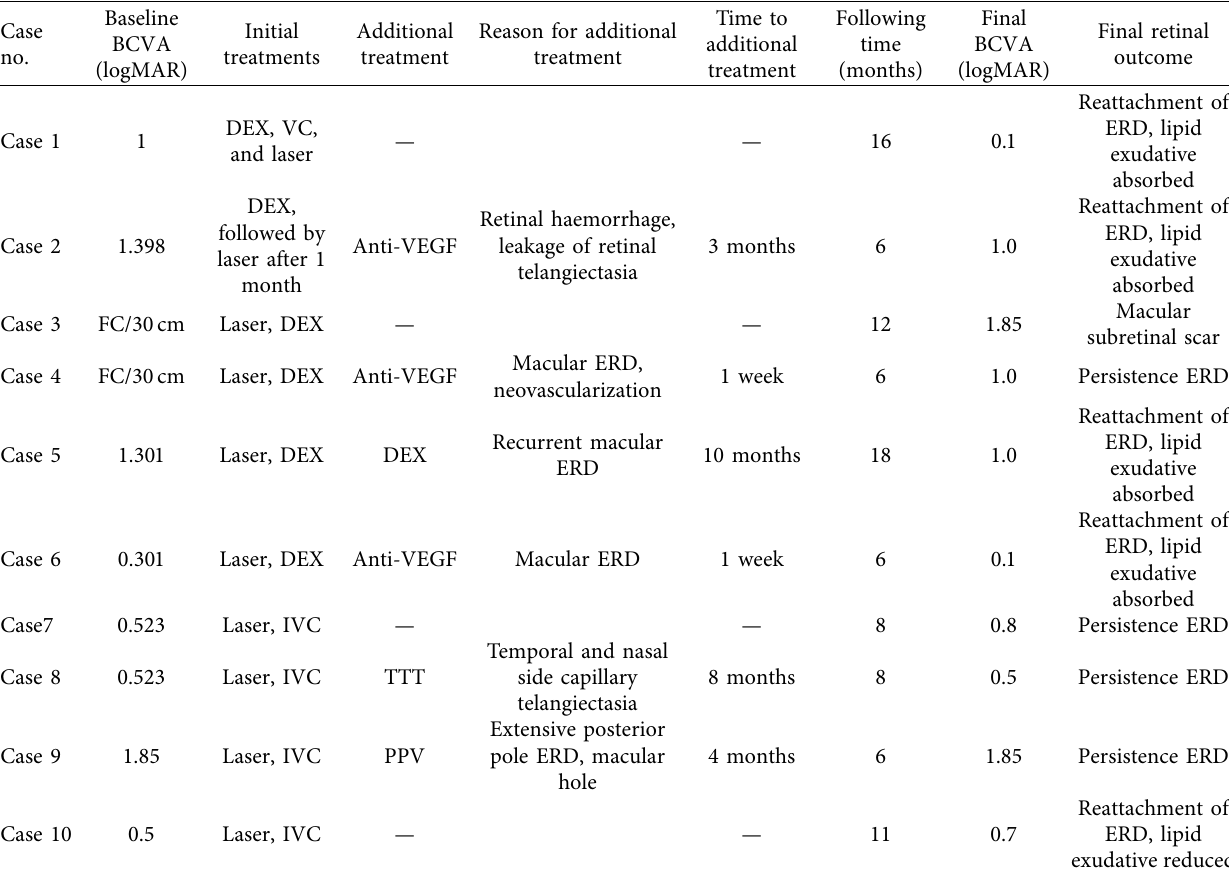
Table 3: Treatments and retinal outcome details of patients with Stage 3A Coats’